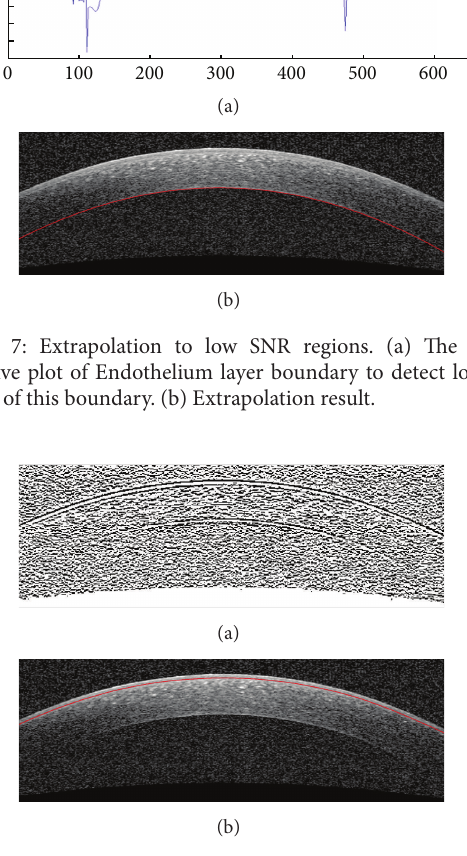
Figure 8: Segmentation of Bowman layer boundary. (a) Horizontal gradient of the enhanced image. (b) Final Bowman layer segmenta- tion result.